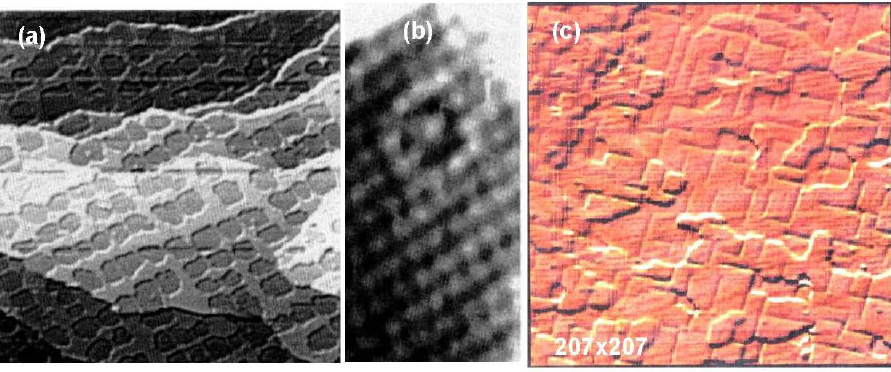
Figure 15. ( a ) A Cu(100) surface covered with c(2 × 2)-N patches; ( b ) a high resolution image of a c(2 × 2)-N patch of ca. 5 × 5 nm 2 [57]; ( c ) A Cu(100) surface fully covered with c(2 × 2)-N layer